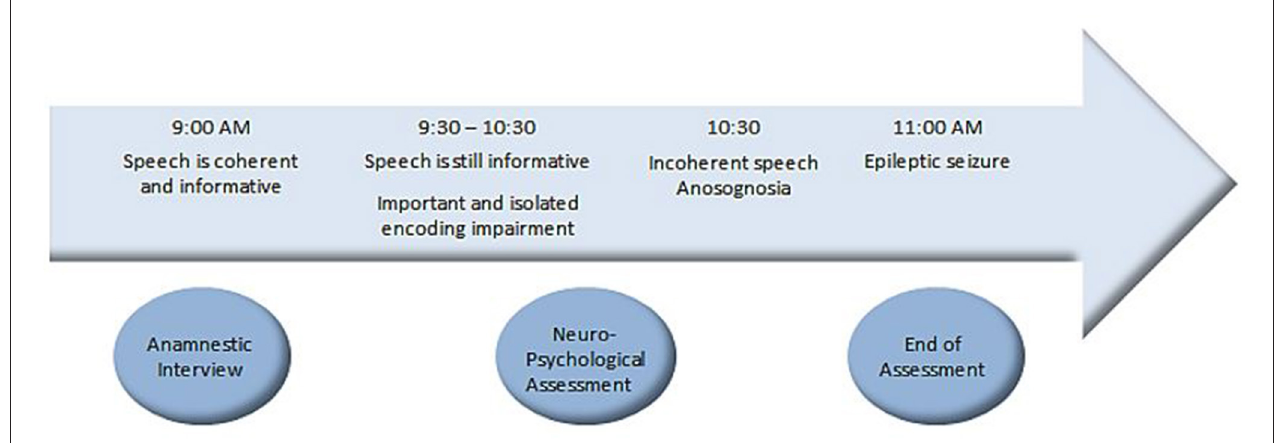
FIGURE 4 | Unfolding